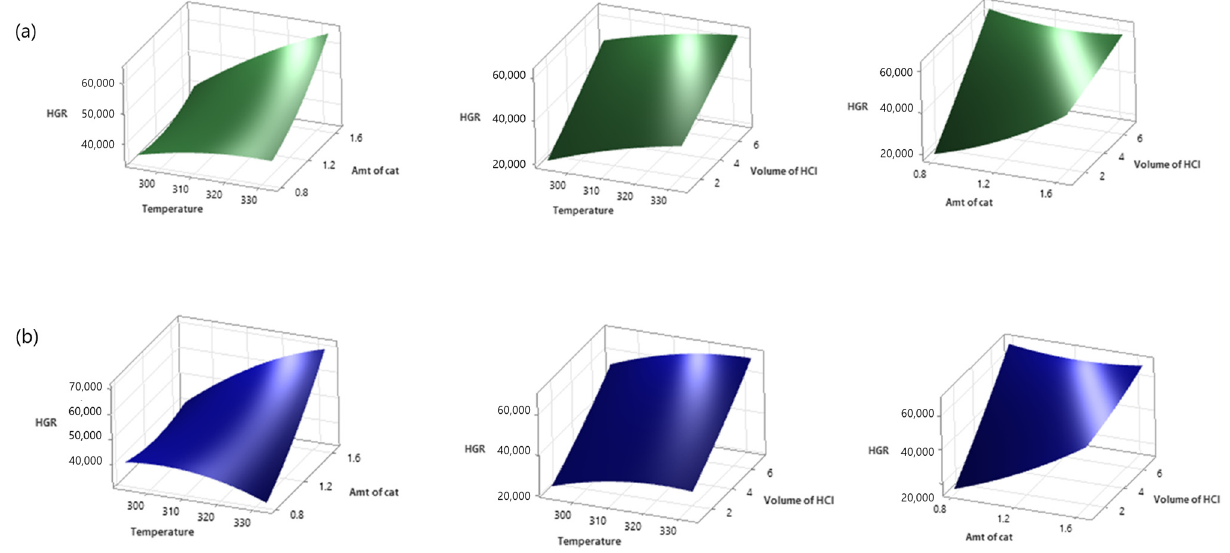
Figure 5. Surface plots of HGR (( a ) NiCr system, ( b ) NiV system; 1.225 g NiCr catalyst, 4 mL 0.5 M HCI at 313 K).